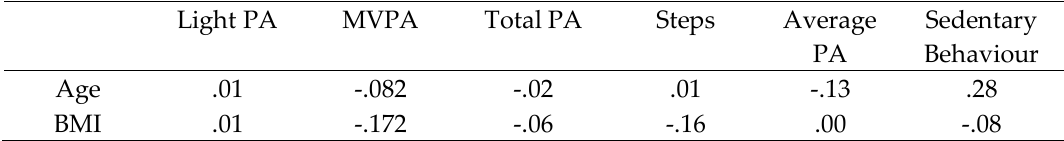
Table 3. Correlations of age and BMI with physical activity and sedentary